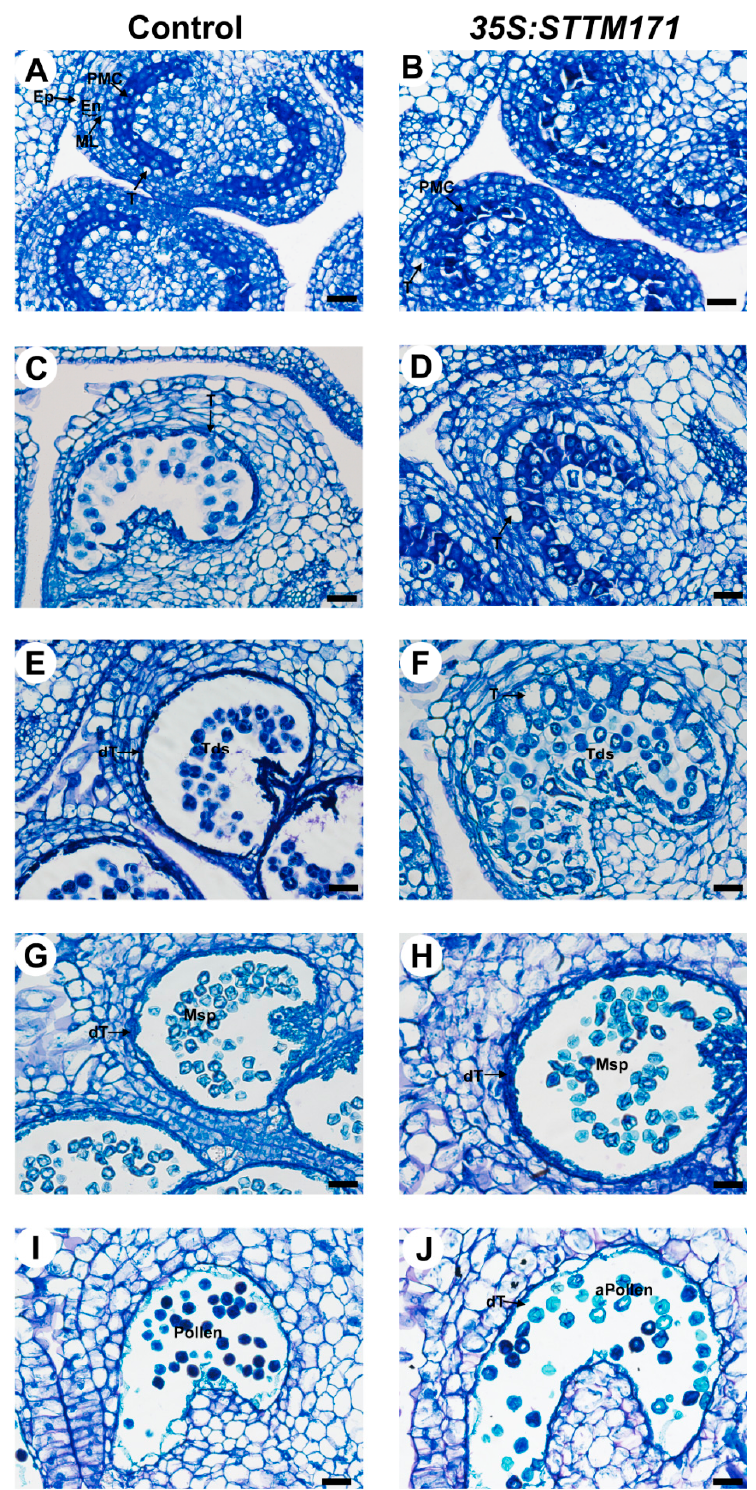
Figure 6. Histological analysis of control and 35S:STTM171 anthers. Pictures of Toluidine-blue stained cross sections of control and 35:STTM171 anthers at subsequent stages of microspore development as follows: ( A , B ) microsporocyte stage, ( C , D ) meiosis stage, ( E , F ) tetrad stage, ( G , H ) microspore stage, ( I , J ) bicellular pollen stage. dT-degenerated tapetum; En-endothecium; Ep-epidermis; ML-middle cell layer; Msp-microspore; MMC-microspore mother cell; T-tapetum; Tds-tetrads; aPollen-aborted pollen. Scale bars = 20 µm.